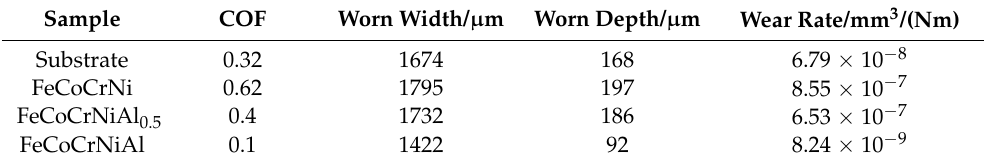
Table 3. Frictional wear performances of coatings with different Al contents.